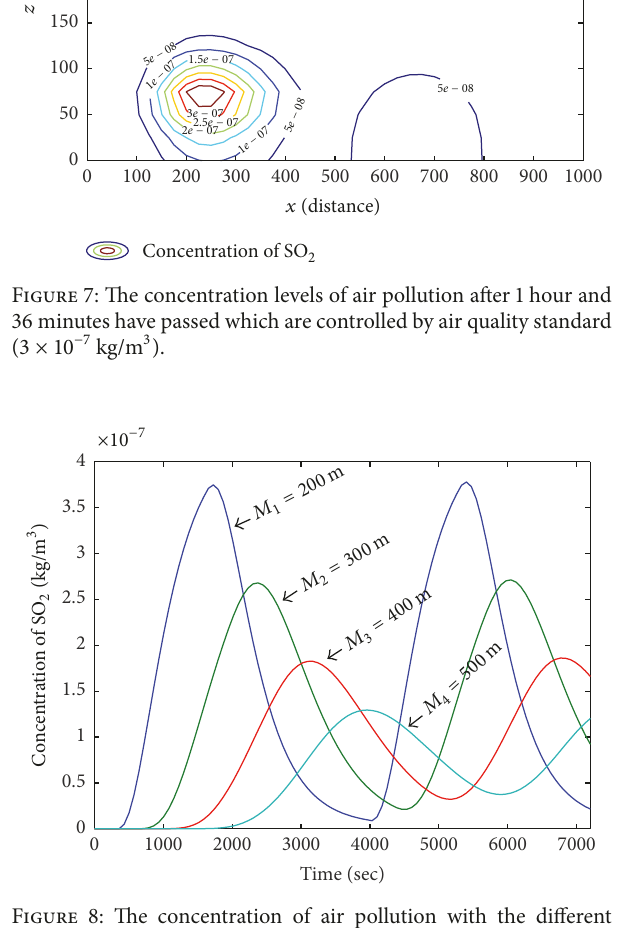
Figure 8: The concentration of air pollution with the different monitoring point at 𝑧 = 50 m by air quality standard ( 3 × 10 −7 kg/m 3